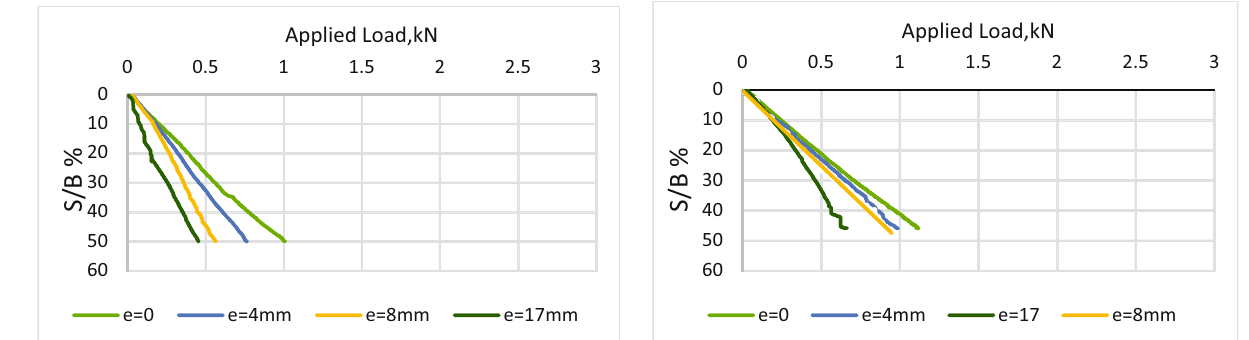
Figure 9: Load – settlement ratio relationship at D s = 0 B . Figure 10: Load – settlement ratio relationship at D s = 0.5 B